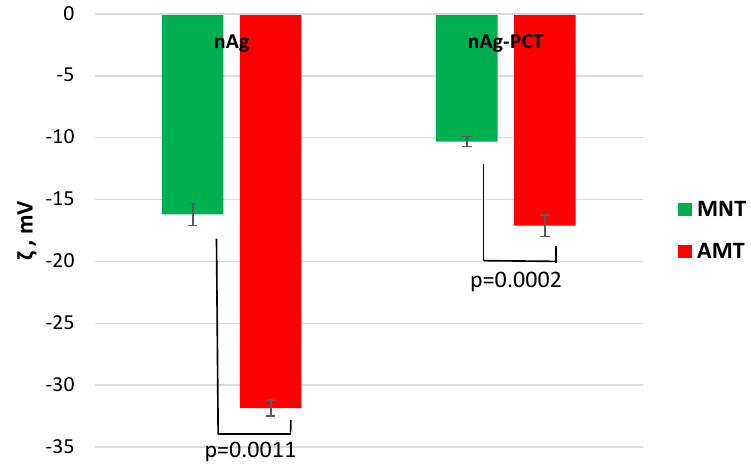
Figure 6. Zeta potential values of the silver-based materials.